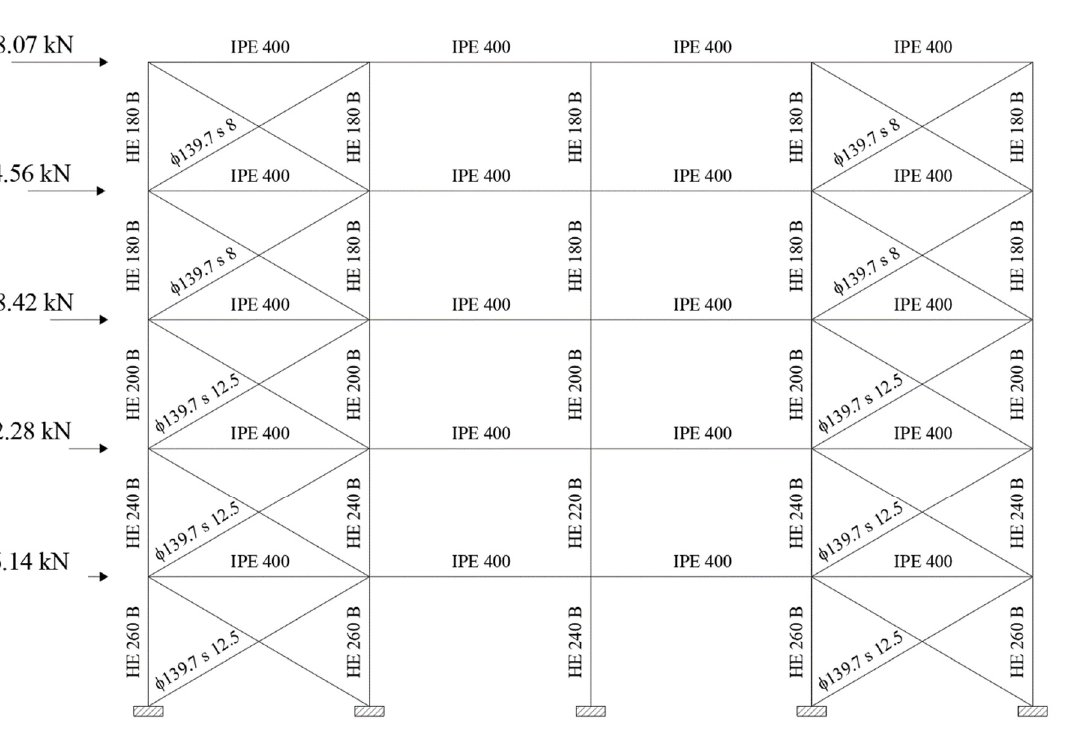
Figure 9. Diagram of the frame with indication of beams, diagonals, columns, and seismic forces (OCBF).